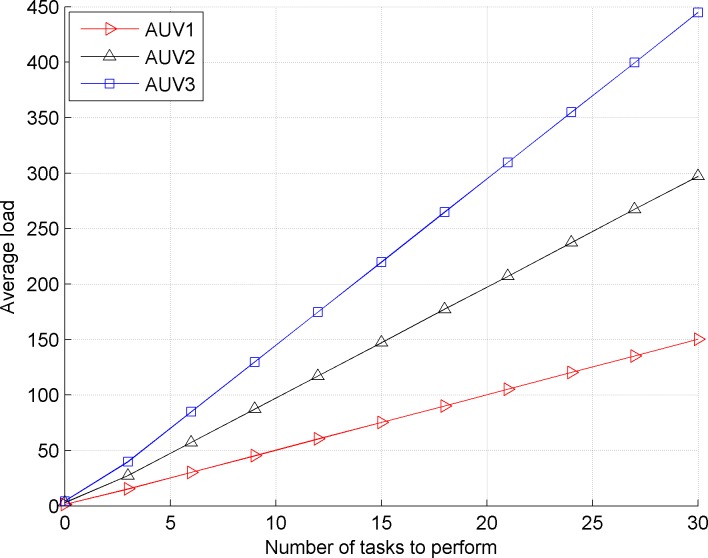
Average load of AUV1, AUV2 and AUV3 in the traditional contract net model AUV2
AUV3.